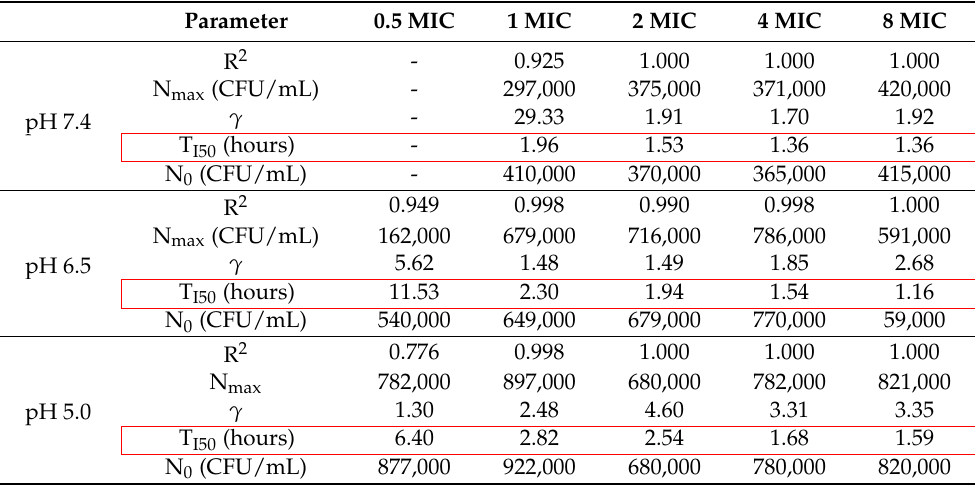
Table 6. Parameters estimated by the sigmoid model minus the base for the ATCC 29213 strain at pH 7.4, 6.5, and